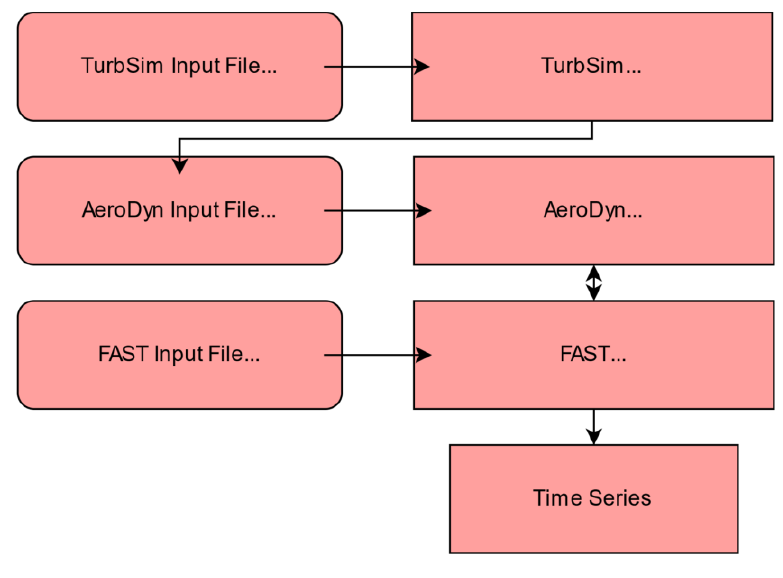
Figure 3. FAST Simulation Procedure